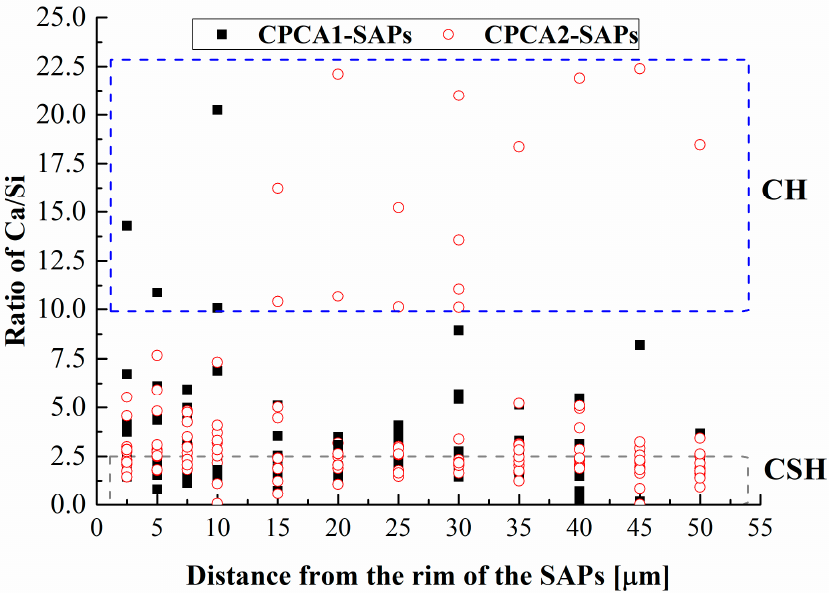
Figure 10. Ca/Si molar ratio as a function of the distance from the rim of the superabsorbent polymers (SAPs) as determined by the EDX.